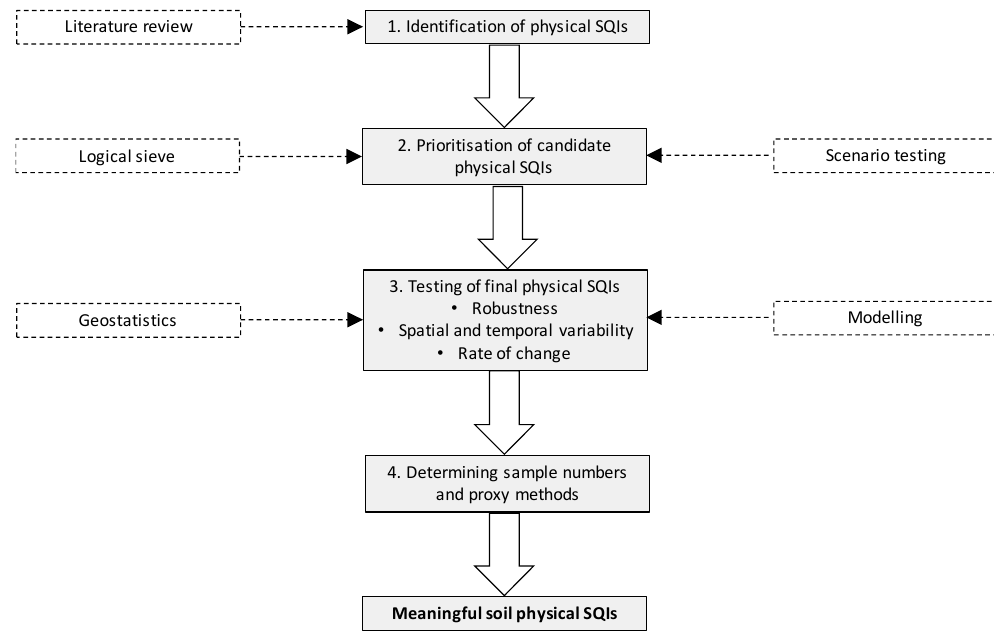
Figure 1. Multi-stage approach taken in the selection of meaningful physical soil quality indicators